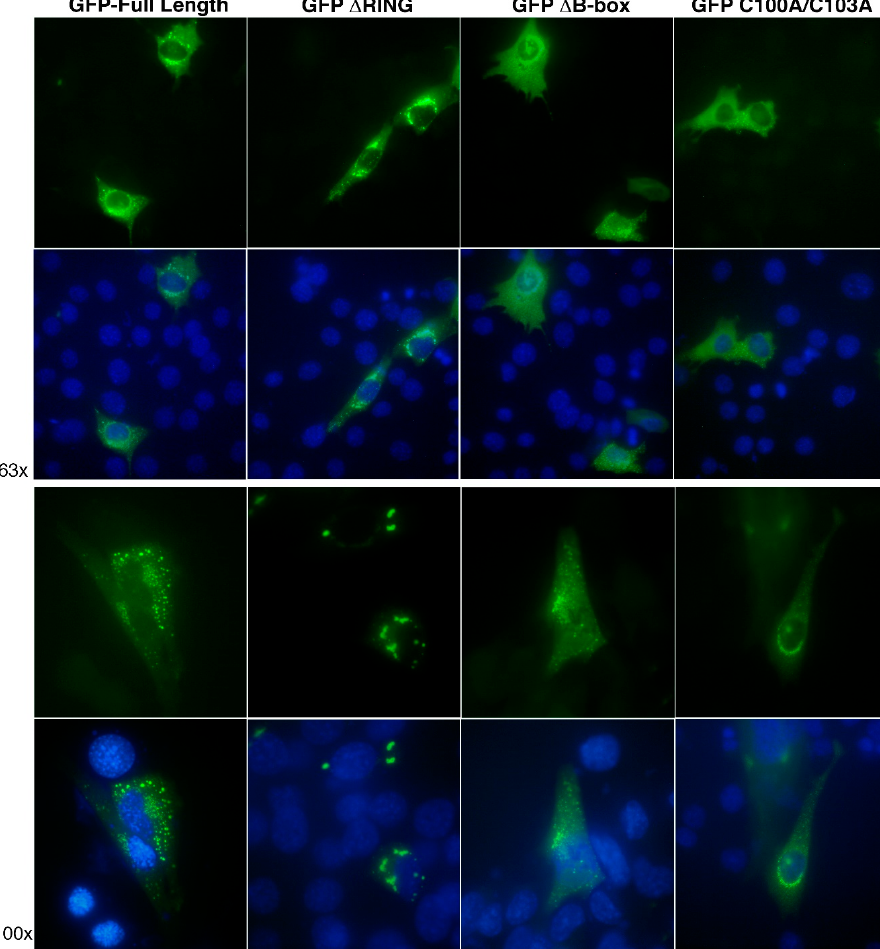
Figure 6. TRIM32’s RING and B-box domains contribute to determine TRIM32 subcellular localization. Representative images of C2C12 myoblasts expressing exogenous GFP-tagged full-length TRIM32 or Δ RING, Δ B-box and C100A/C103A mutants. Localization was assessed by fluorescence imaging with nuclei counterstaining (DAPI) at 63× and 100× magnification as indicated.